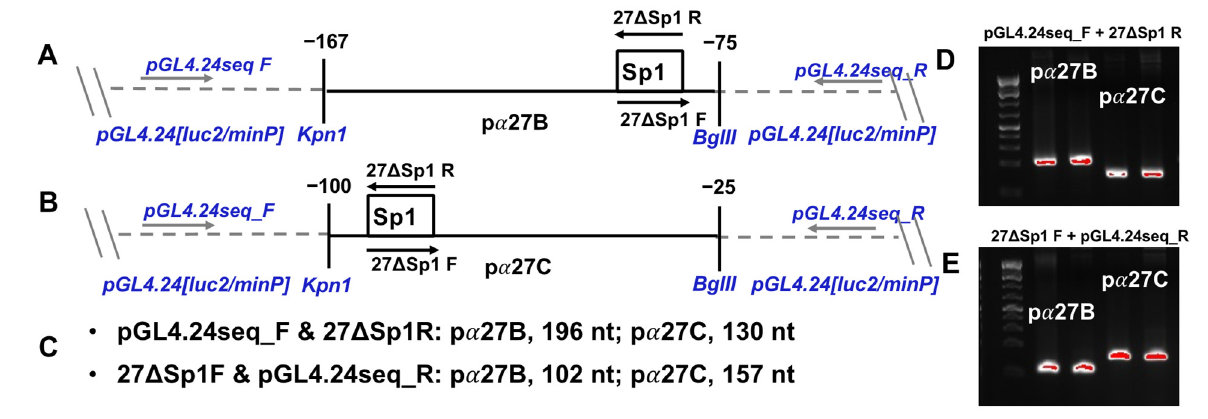
Figure 2. Schematic of ICP27 enhancer fragments in luciferase reporter plasmid and position of PCR primers used for ChIP. The p α 27B (Panel ( A )) and p α 27C (Panel ( B )) enhancer fragments cloned into pGL4.24[luc2/minP] upstream of the minimal promoter. Enhancer fragments, denoted by black lines, are shown with nucleotide positions relative to the transcriptional initiation site. Sp1 binding site (white box) is shown in the approximate location of each enhancer fragment, along with the primer pair used for mutagenesis, 27 ∆ Sp1-F and -R. Luciferase reporter plasmid pGL4.24[luc2/minP] (grey dashed line) is shown with Kpn1 and BglII restriction sites used to insert enhancer fragments. Approximate positions of pGL4.24 seq-F and -R primers indicated. Panel ( C ): Primer pairs used to PCR amplify ChIP DNA and size of PCR products generated from each primer pair and enhancer fragment. Panels ( D , E ): PCR product from the indicated primer pair on each enhancer fragment, visualized on a 2% agarose gel stained with ethidium